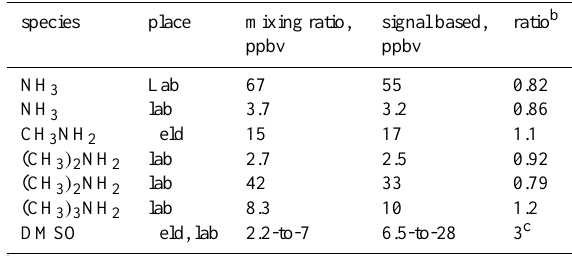
Table 2. Laboratory and field (OK) a calibrations. species place mixing ratio, signal